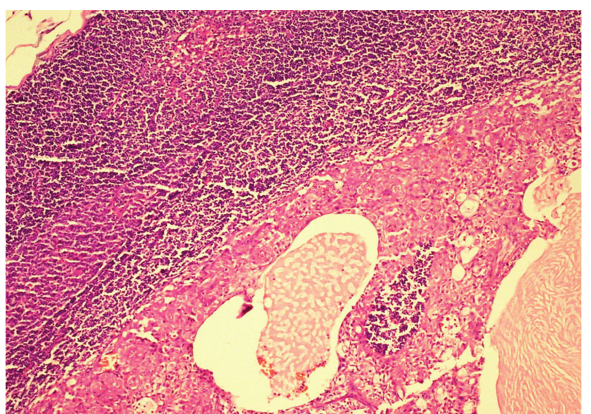
figure 3 - histopathology showing lymph node metastasis h&E X